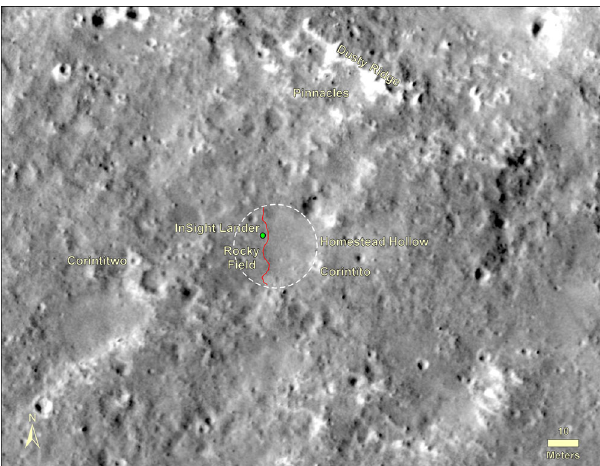
Fig. 4 HiRISE image of region in view from the lander. Image shows the lander (green dot), and rocks, craters and bedforms observed in surface images. Note the relatively fresh, rocky ejecta crater Sunrise (~100 m diameter) about 400 m to the east and nearby bedforms observed from the lander (The Wave) that are typically near the rim or inside craters. Panoramas show terrain about 50 m to the north to the rim of a degraded crater (~100 m diameter) where bedforms (Dusty Ridge) and rocks (The Pinnacles) can be seen. Also note Corinto secondary craters ( fi ve yellow arrows and Corintito) with their characteristic bright ejecta. Portion of